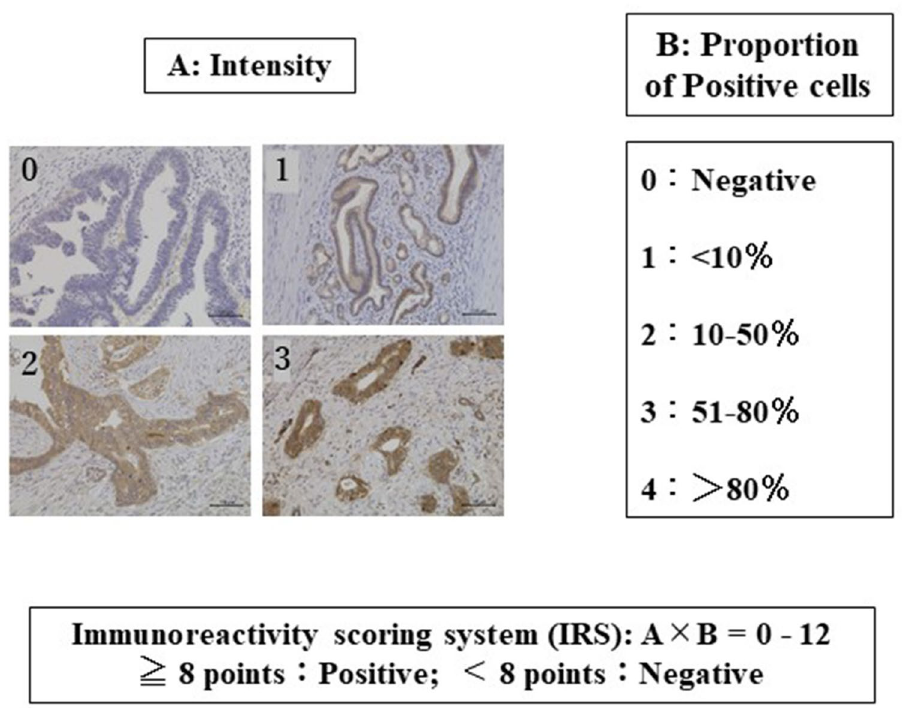
Figure 5. Immunoreactive score (IRS). The Immunoreactivity scoring system (IRS), which is a combination of the intensity (1 to 4 points) and proportion of positive cells, was used. 8 points and more were judged to be IRS positive. Scale bar: 100